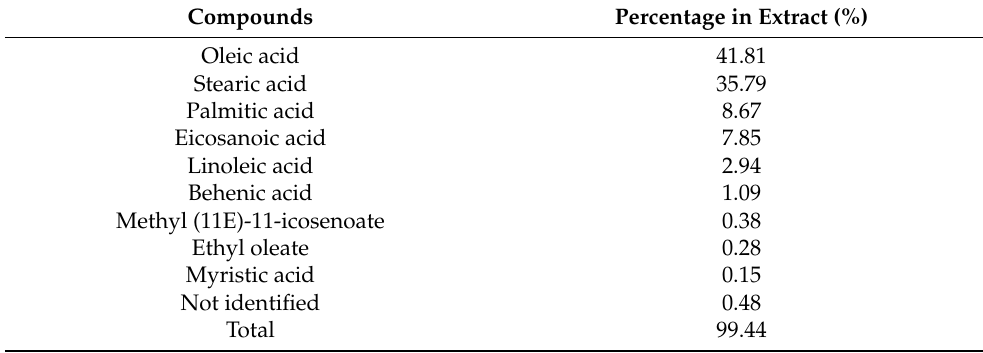
Table 1. Chemical composition of the Cupuaçu seed extract in percentage determined by